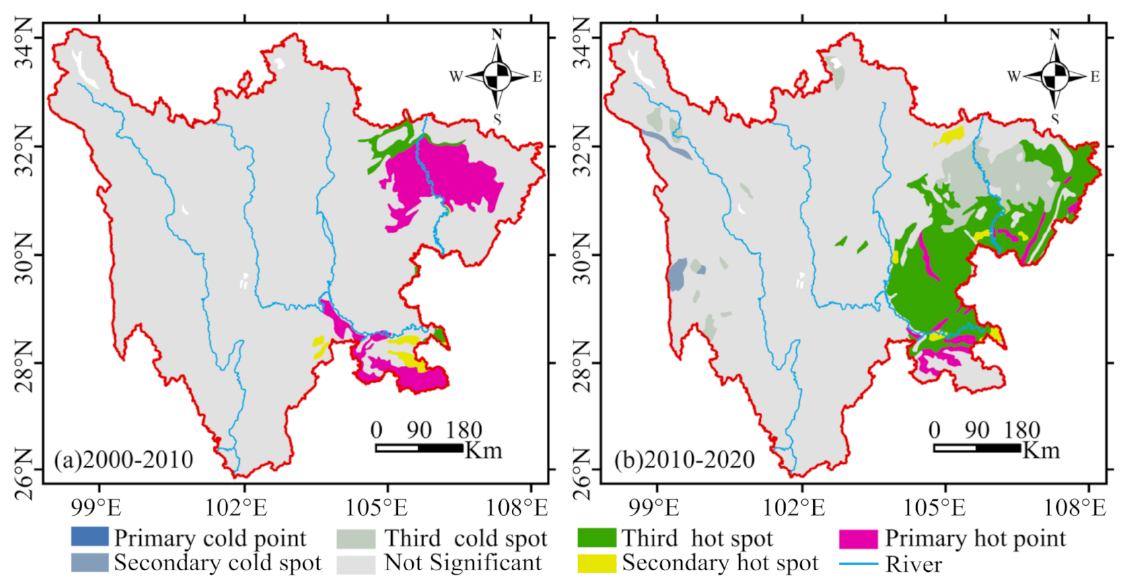
Figure 8. Identification of hot spots of cultivated land area change from